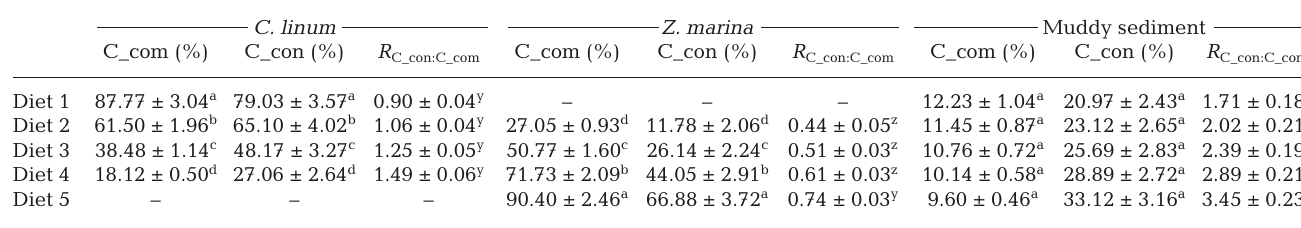
Table 6. Carbon contributing proportions to sea cucumbers of the 3 ingredients in 5 experimental diets (C_con; %), carbon composition per- centages of the ingredients (C_com; %), and their ratios ( R C_con:C_com ) of the 3 ingredients in 5 diet treatments (mean ± SD, n = 4). R C_con:C_com, is a new index for measuring the feeding preference of Apostichopus japonicus to different diet ingredients. Chaetomorpha linum and Zostera marina were not present in diets 5 and 1, respectively. C_con of the ingredients in diets 2 to 4 are calculated based on the values of C_con in diets 1 and 5, and by the equations of the absorption rate approach. The values of C_com and C_con with different letters (a, b, c, d) in the same column are significantly different from each other, and the values of R C_con:C_com with different letters (x, y, z) in the same row are significantly different from each other (ANOVA and Tukey’s multi-comparison; p < 0.05)